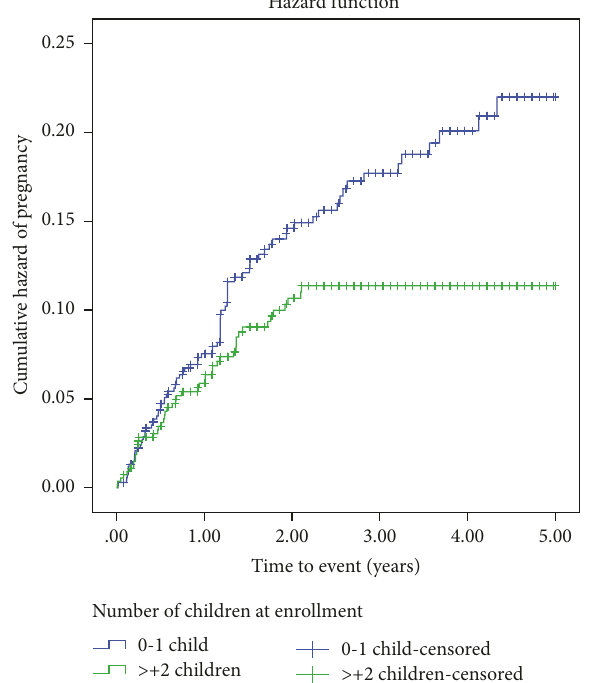
Figure 2: Kaplan-Meier curves of pregnancy showing hazard of pregnancy among women receiving ART treatment from Sep. 2011 toAug.2015inDebreMarkosReferralHospital,NorthwestEthiopia, 2016 ( 𝑁 = 1 , 239